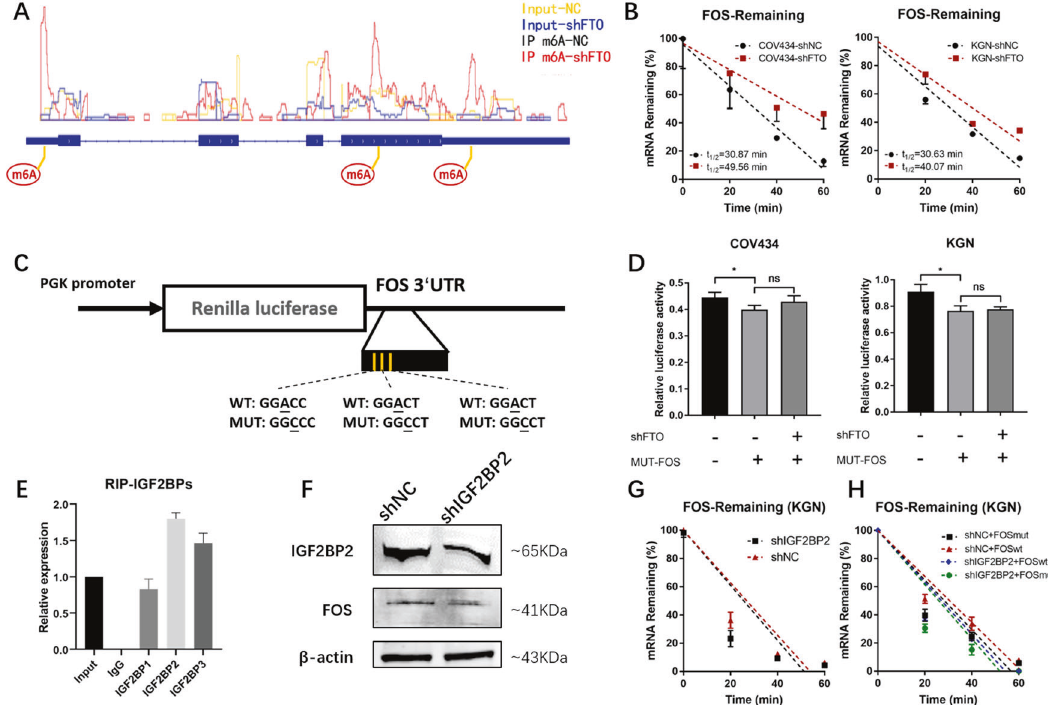
Fig. 4 The increase in m6A modi fi cation in the 3 ′ UTR resulted in increased stability of the FOS mRNA. A MeRIP-seq showed the different m6A peaks of FOS mRNA in COV434-shFTO compared to COV434-shNC. IP immunoprecipitation. B Transcriptional inhibition experiments showed a longer half-life of FOS mRNA in FTO-knockdown COV434 and KGN cells. C Wild-type or m6A consensus sequence mutant FOS-3 ′ UTR cDNA was fused behind the Renilla luciferase reporter. D Relative luciferase activity of the wild-type and mutant FOS 3 ′ UTR reporter vectors in FTO-knockdown COV434 and KGN cells. E RIP-qPCR showed the combination of IGF2BPs antibodies and FOS-mRNA. F Western blots showed lower FOS expression in IGF2BP2-knockdown KGN compared with negative control. G Transcriptional inhibition experiments showed a shorter half-life of FOS mRNA in IGF2BP2-knockdown KGN cells. H Transcriptional inhibition experiments of wild-type and mutant FOS 3 ′ UTR reporter vectors in IGF2BP2-knockdown (and negative control) KGN cells. All experiments were performed three times. The error bars indicate SD; * p < 0.05.